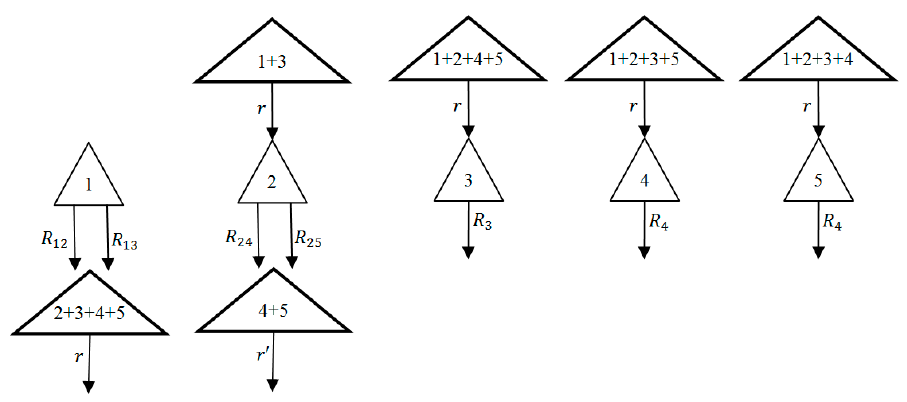
Figure 7. The sub-problems of PAP using the aggregation–decomposition dynamic programming (AD-DP) method [28].